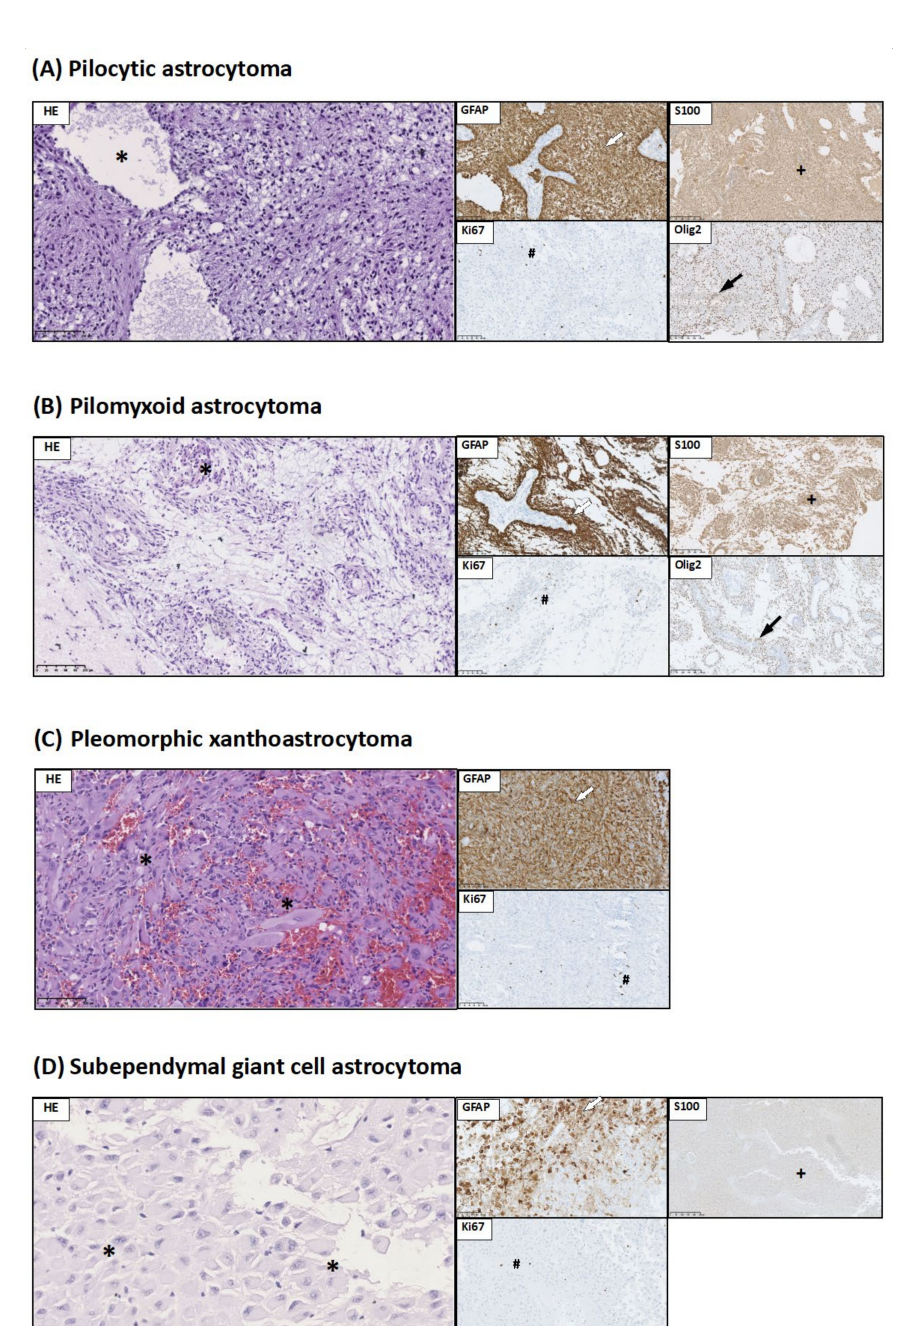
Figure 5. Histological and immunohistochemical staining of group 5 pediatric brain tumors: pilocytic astrocytoma, pilomyxoid astrocytoma, pleomorphic xanthoastrocytoma (PXA), and subependymal giant cell astrocytoma (SEGA). HE staining as well as GFAP immunohistochemical staining and Ki67 were performed to visualize typical manifestations in these types of tumor tissue. ( A ) Pilocytic astrocytoma: microcystic pattern (*). GFAP strong positive staining in tumor tissue (white arrow). S100 immunoreactivity in neoplastic cells (+). Low Ki67 LI in tumor tissue (#). Olig2 immunoreactivity in neoplastic cells (black arrow) ( B ) Pilomyxoid astrocytoma: myxoid changes in stroma and angiocentric pattern (*). GFAP strong positive staining in tumor tissue (white arrow). S100 immunoreactivity in neoplastic cells (+). Low Ki67 LI in tumor tissue (#). Olig2 immunoreactivity in neoplastic cells (black arrow). ( C ) PXA: pleomorphic cells (*). GFAP-positive staining in tumor tissue (white arrow). Low Ki67 LI in neoplastic cells (#). ( D ) SEGA: ganglion-like cells (*). GFAP-positive staining in tumor tissue (white arrow). Low Ki67 LI in neoplastic cells (#). Weak of S100 immunoreactivity in neoplastic cells (+). Preparations were scanned at original magnification 40 × , and digital magnification presented on image is 20 × for HE